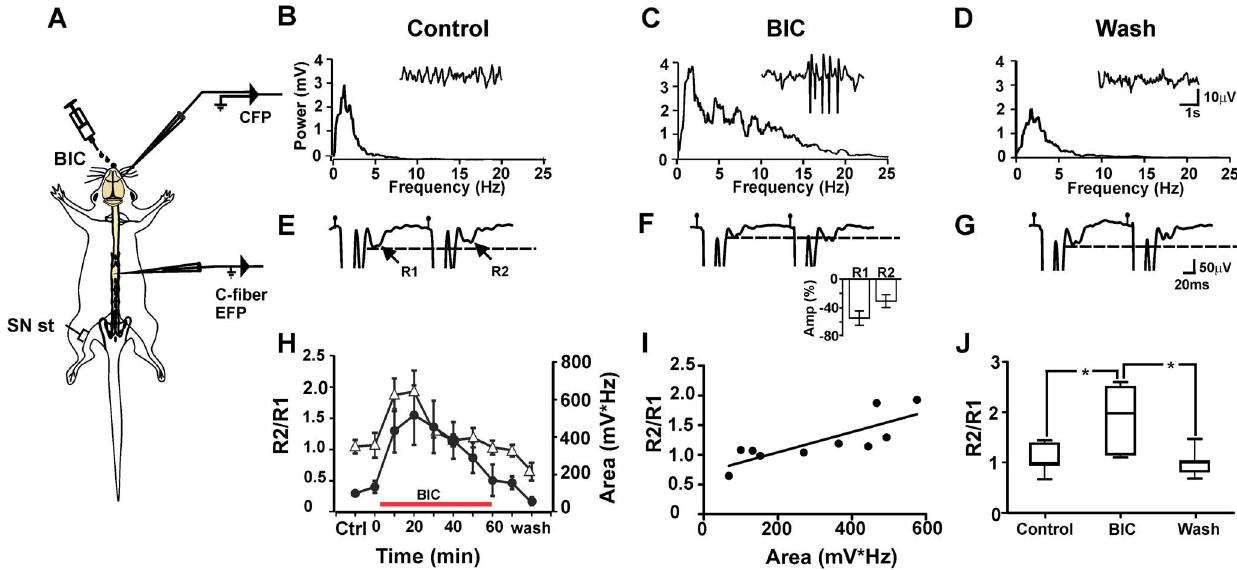
Figure 3. Sensorimotor cortex modulates the PPR of C–fiber EFPs. A, Schematic diagram of the experimental arrangement. B, Power spectrum of the spontaneous cortical activity recorded for 30 sec. The insert shows a sample of spontaneous field potential recorded in the sensorimotor cortex (1000 m m depth, 2.5 mm caudal to bregma, and 3 mm from the midline). C, the same but after 20 min of BIC topical administration (100 m L, 100 m M) on the surface of the sensorimotor cortex. D, the same but after wash. E–G, representative electrophysiological recordings (arrows) of C–fiber evoked responses (R1 and R2) produced by a pair of consecutive stimuli in the SN in control conditions (E), after BIC administration (F), and during wash (G). The insert shows the percent inhibition of the C–fiber EFPs R1 and R2 after 20 min of BIC administration onto the cortex. H, Changes in the PPR (R2/R1) (triangles), and the area below the curve computed from the power spectra of cortical activity during BIC administration (circles). I , graph showing a significant positive correlation between the PPR and the area below the curve computed from the cortical activity power spectra (r=0.86). J , box plot of the PPR computed in 7 experiments in control conditions, after 20 min of BIC administration, and during wash. *p , 0.05, Kruskall–Wallis